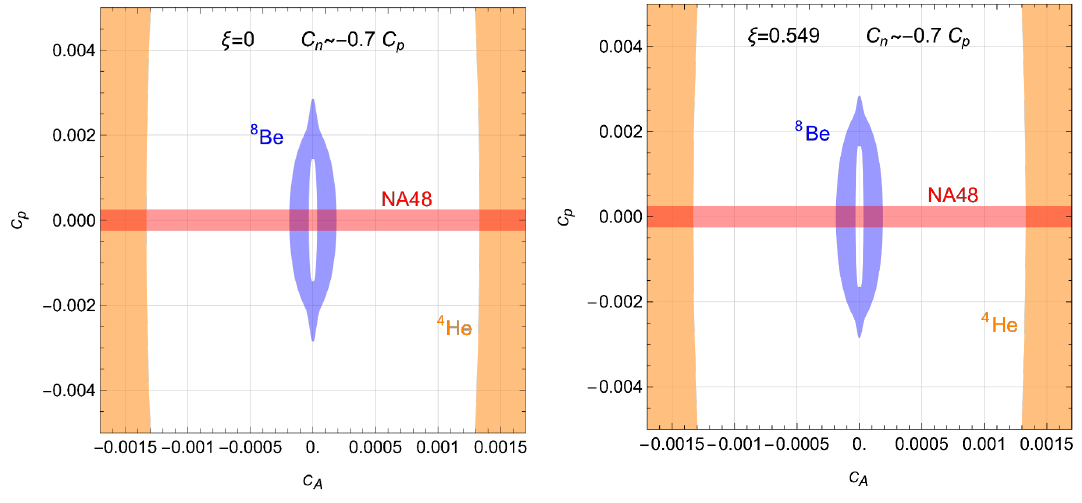
Figure 7 . Regions of the C p − C A couplings for the minimal SM extension with a new U(1) X symmetry where the 8 Be (blue) and 4 He (orange) anomalous ATOMKI transition can be explained at 1 σ . Inside the red region the NA48 bound is satisfied. In the left and right panel we assume ξ = 0 and ξ = 0 . 549 respectively, see appendix B.1 for